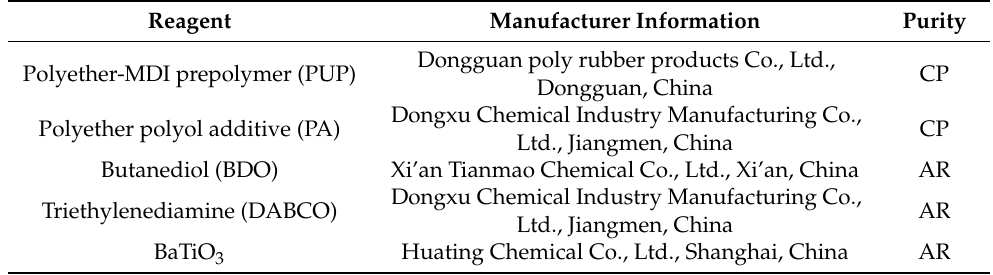
Table 1. The main reagents.